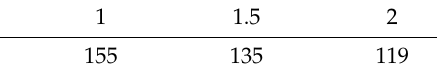
Table 3. Austenite grain size with different boron content (nm). 2%, the refinement effect of the structure was the best. The grain size of austenite is 119 ± 2.8 nm.